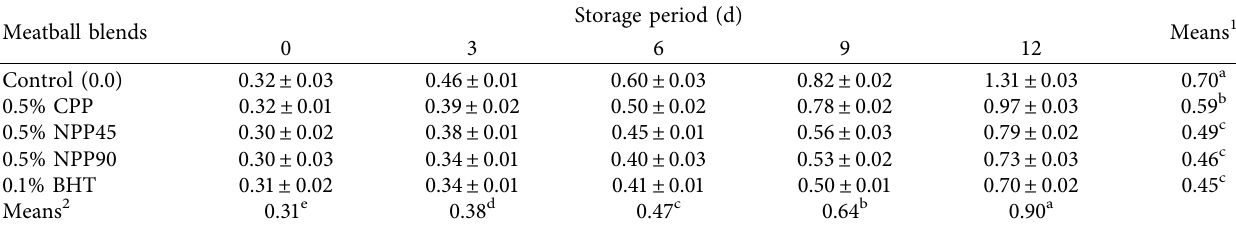
Table 3: Impact of nano-pomegranate peel on thiobarbituric acid (mg malonaldehyde/kg sample) of cold stored meatballs. Meatball blends